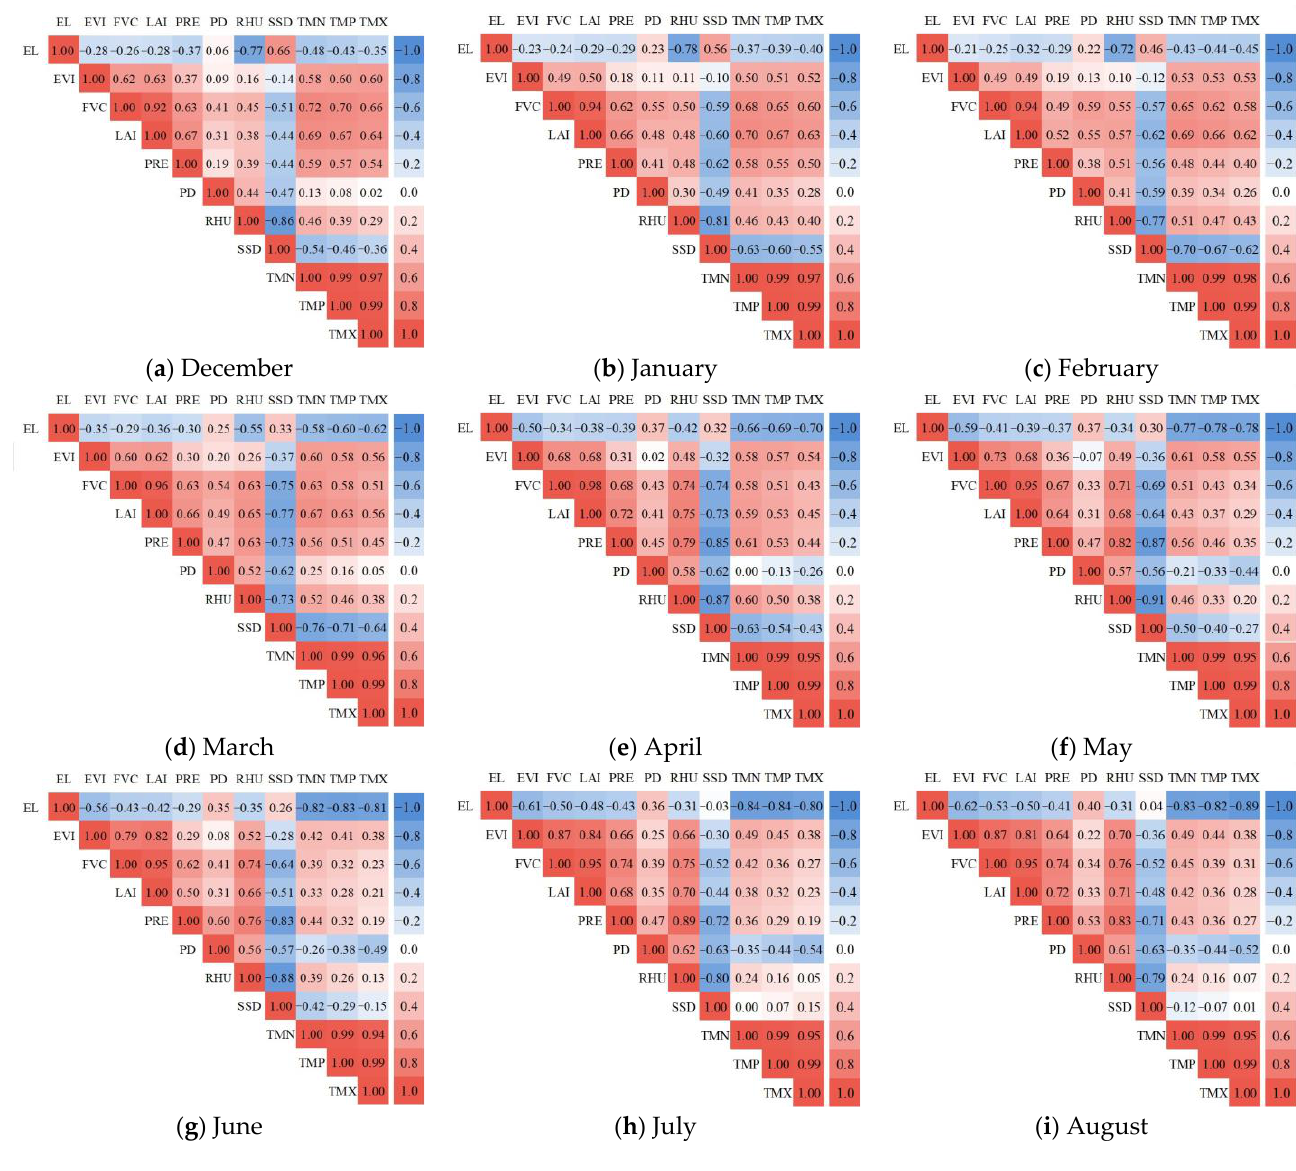
Figure 3. Pearson’s correlation coefficient results for each month of variables from December to August. ( a ): The monthly variables are the five-year average values of the month from 2009 to 2013. ( b – i ): The monthly variables are the five-year average values of the month from 2010 to 2014. Table 1. The Gini importance of variables for each month. The final variables used for modeling are shown in Table 2. From December to March, TMN has the largest weight among the three temperature variables, TMP has the largest weight from April to June, and TMX has the largest weight from July to August, so different temperature variables were selected in different months. Table 2. List of the variables used for